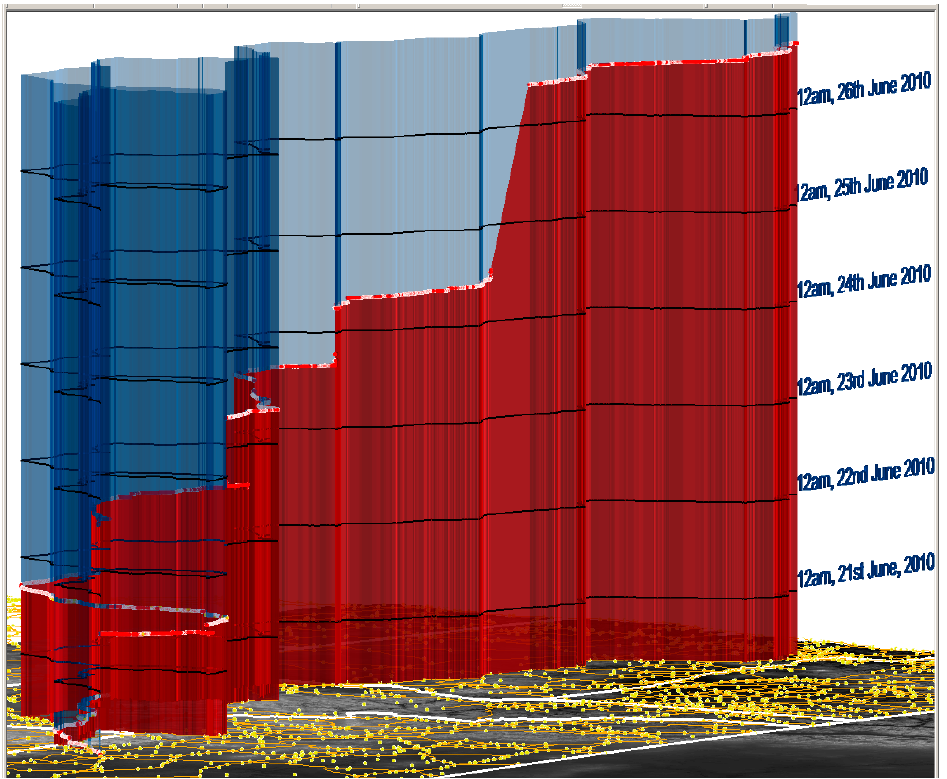
Figure 6. About a week’s worth of holiday trip shown in a time-geographic environment in ArcGIS ArcScene. View is towards the southwest across the northwest US. The route, depicted as a Red Curtain, is from just east of the Rockies to the Oregon coast.